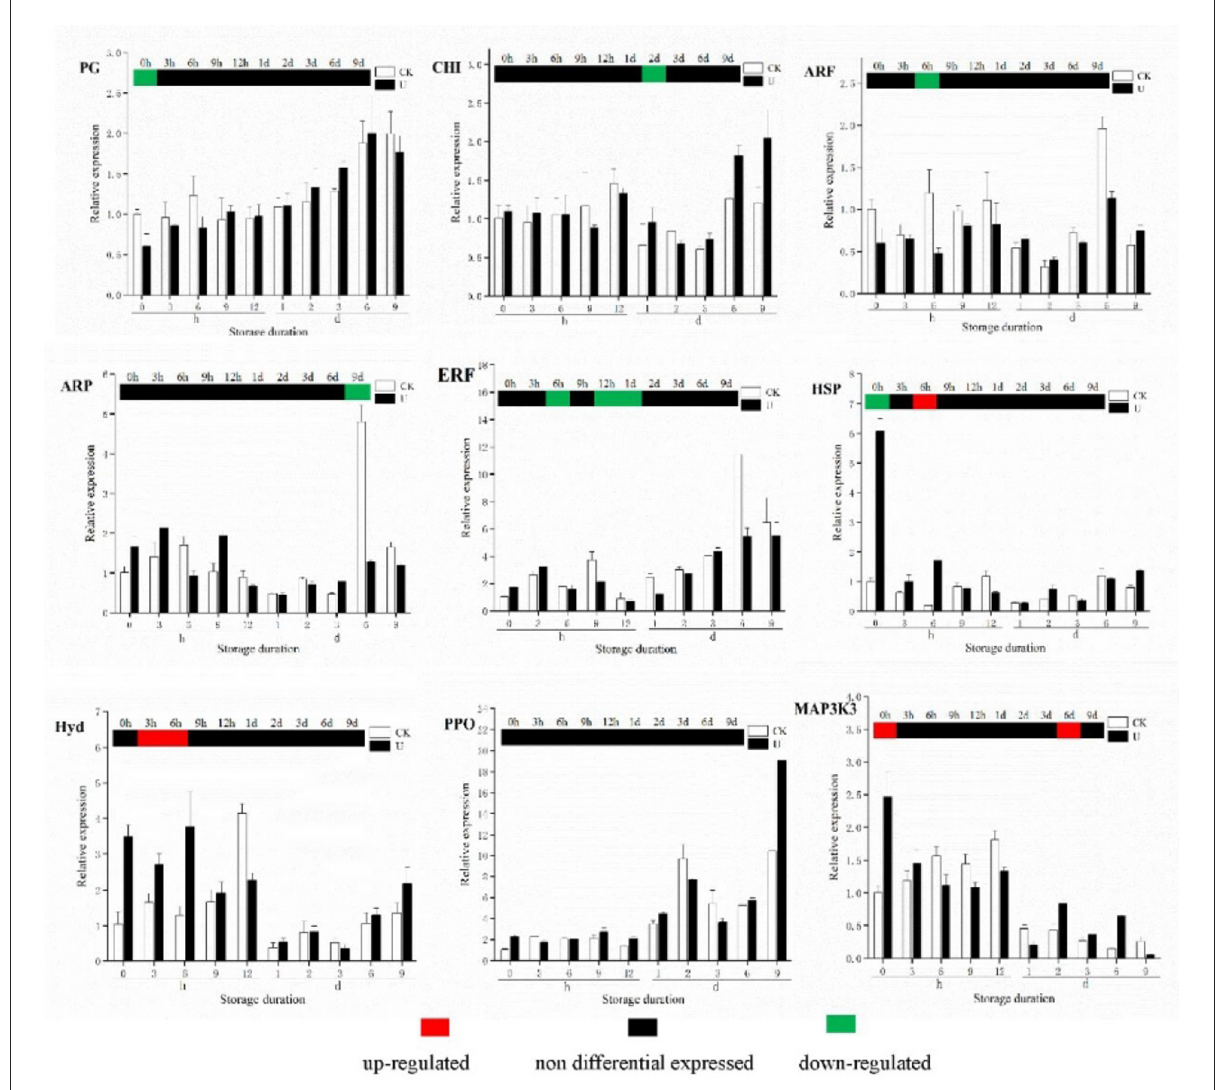
FIGURE9 qRT-PCR validation of selected genes in strawberry after treatments. The relative expression of each gene was calculated based on its expression in the CK_0h sample; the columns was the qRT-PCR results of the selected gene, and the heat map above the columns was the RNA-seq